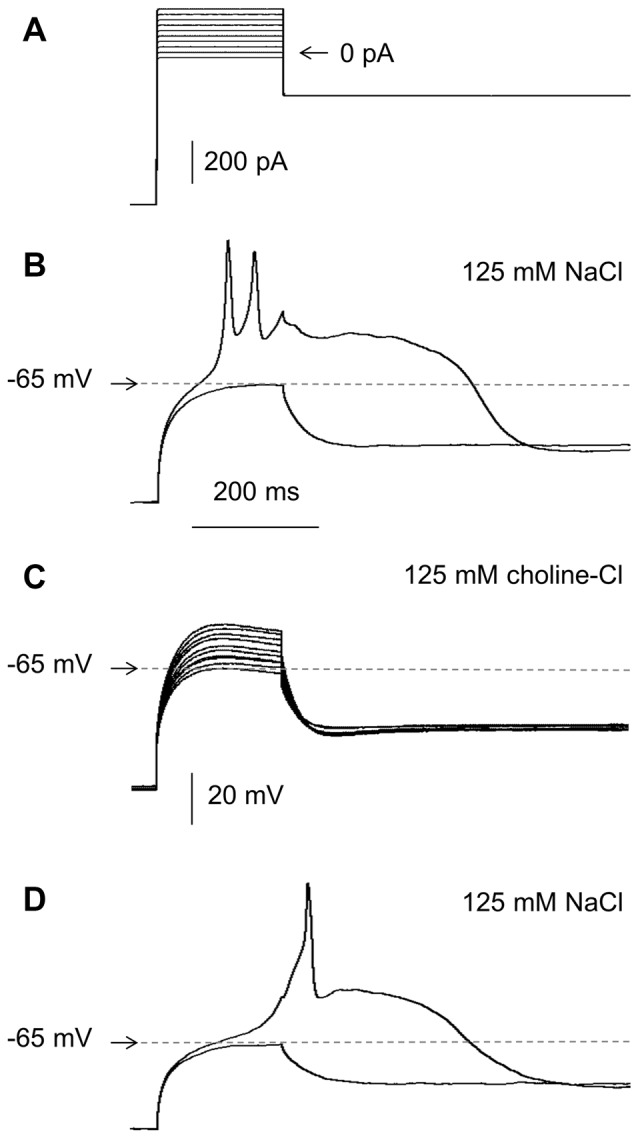
Effects of the extracellular concentration of Na+ on RD in the absence of Ca++ in the extracellular solution. (A) Portion of the current protocol applied to evoke the membrane potential changes shown in (B–D) (compare to Figure 1Aa). (B) RD evoked in the presence of 125 mM of NaCl in the extracellular solution. (C) Membrane potential changes recorded after replacing 125 mM of NaCl with 125 mM of choline-Cl in the extracellular solution. (D) RD evoked after choline chloride washout (replacing 125 mM of choline chloride with 125 mM of NaCl).